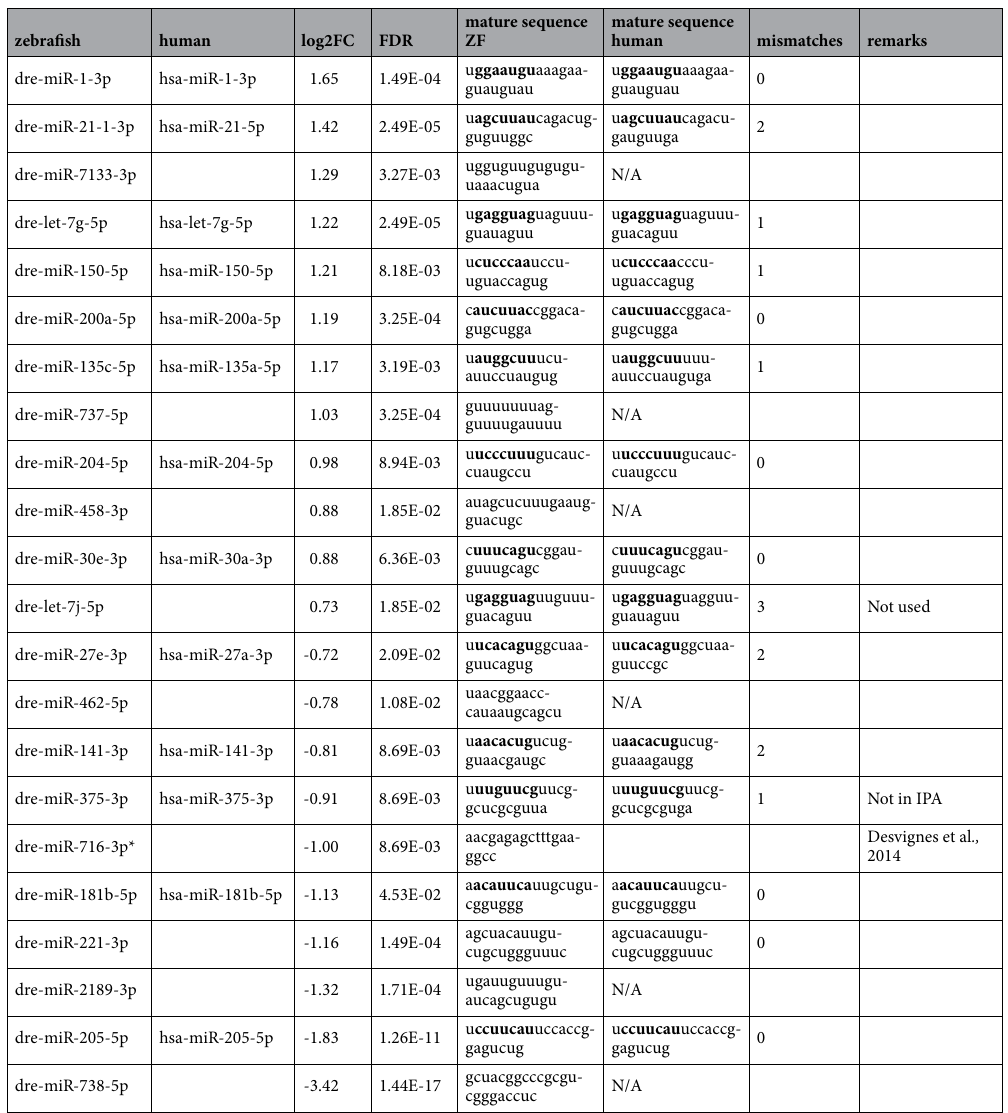
Table 1. Differentially expressed miRNAs and their human orthologues. Pairwise comparison between generations F 1 from exposed (8.7 mGy/h γ-radiation) (F 1 -γ) and control parents (F 1 -C) (log2FC > 0.6, p < 0.05, FDR < 0.05). In bold are the seed sequences. [*] Novel miRNA reported by Desvignes et al. 60 .